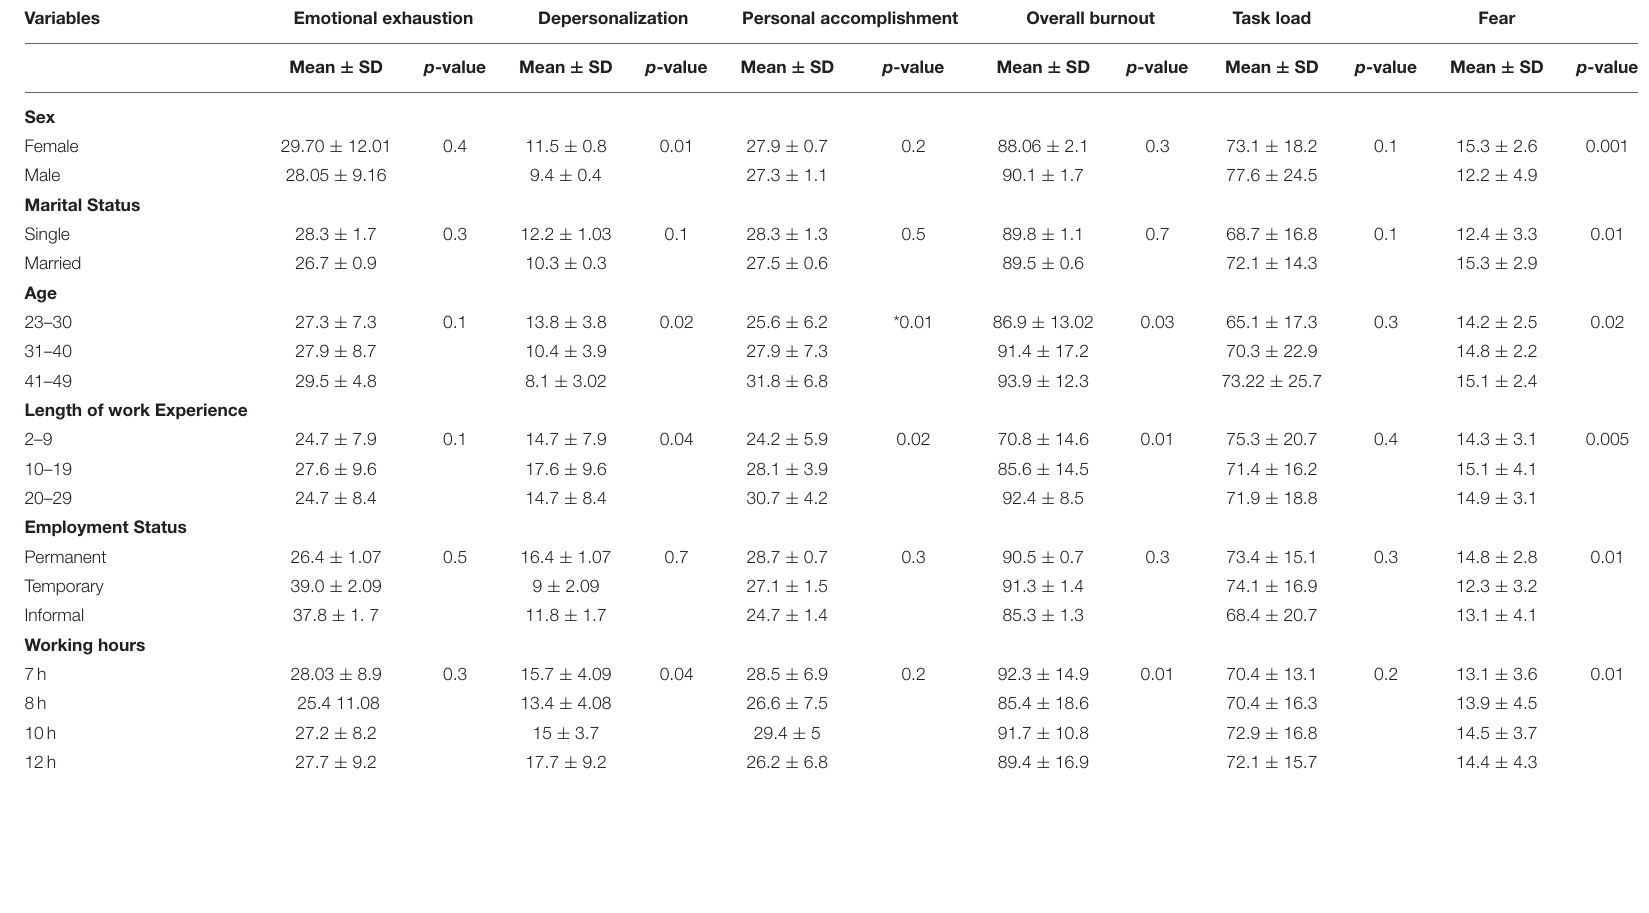
TABLE 4 | Differences in the dimensions of burnout, overall burnout, task load, and fear of COVID-19 in categorized subgroups in terms of individual and work characteristics in hospital